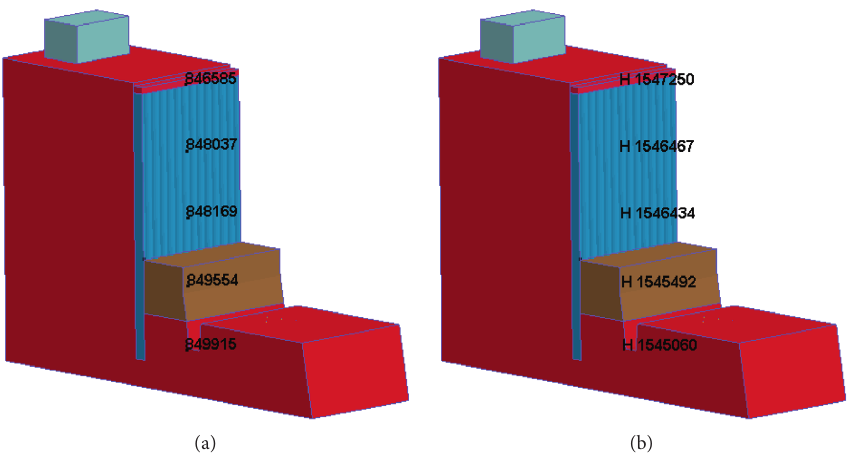
Figure 10: Axis characteristic points of the supporting pile: (a) nodes; (b) the units corresponding to the nodes.